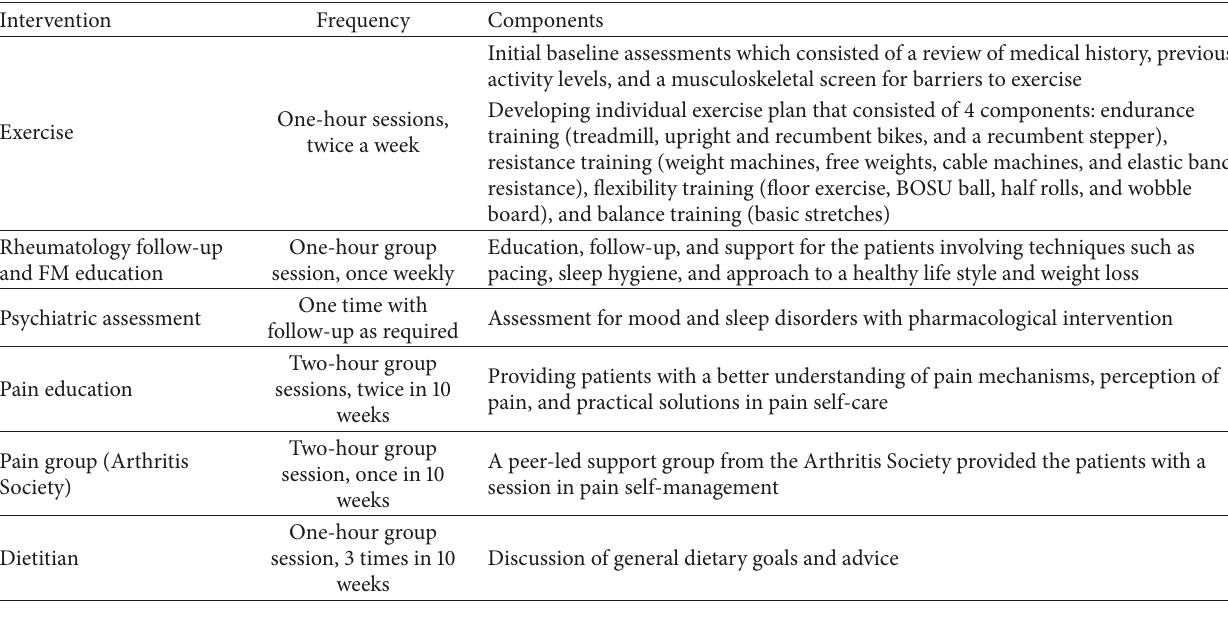
Table 1: Description of the interventions in the model of care.